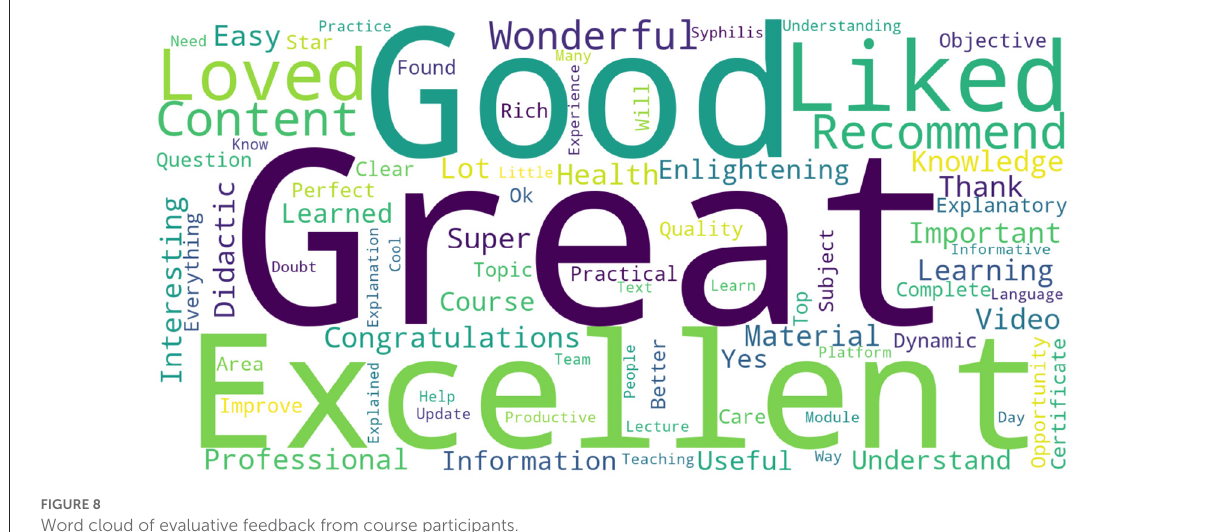
FIGURE8 Word cloud of evaluative feedback from course participants.